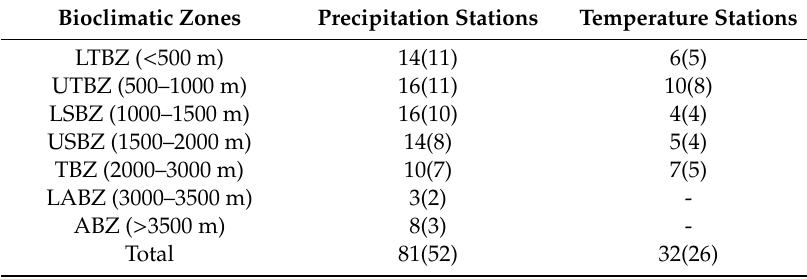
Table 1. Total number of precipitation and temperature stations in each bioclimatic zone in CHAL. Numbers in parentheses indicate stations having complete data